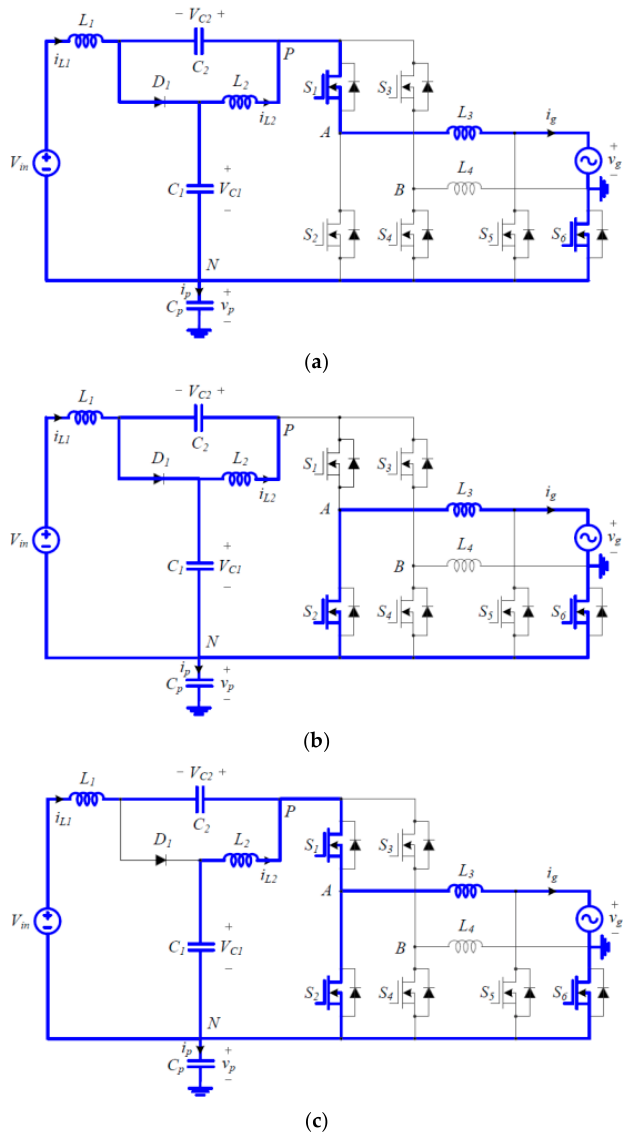
Figure 3. Switching circuit diagrams of the proposed inverter for a positive grid cycle: ( a ) powering state; ( b ) freewheeling state; ( c ) shoot-through state.